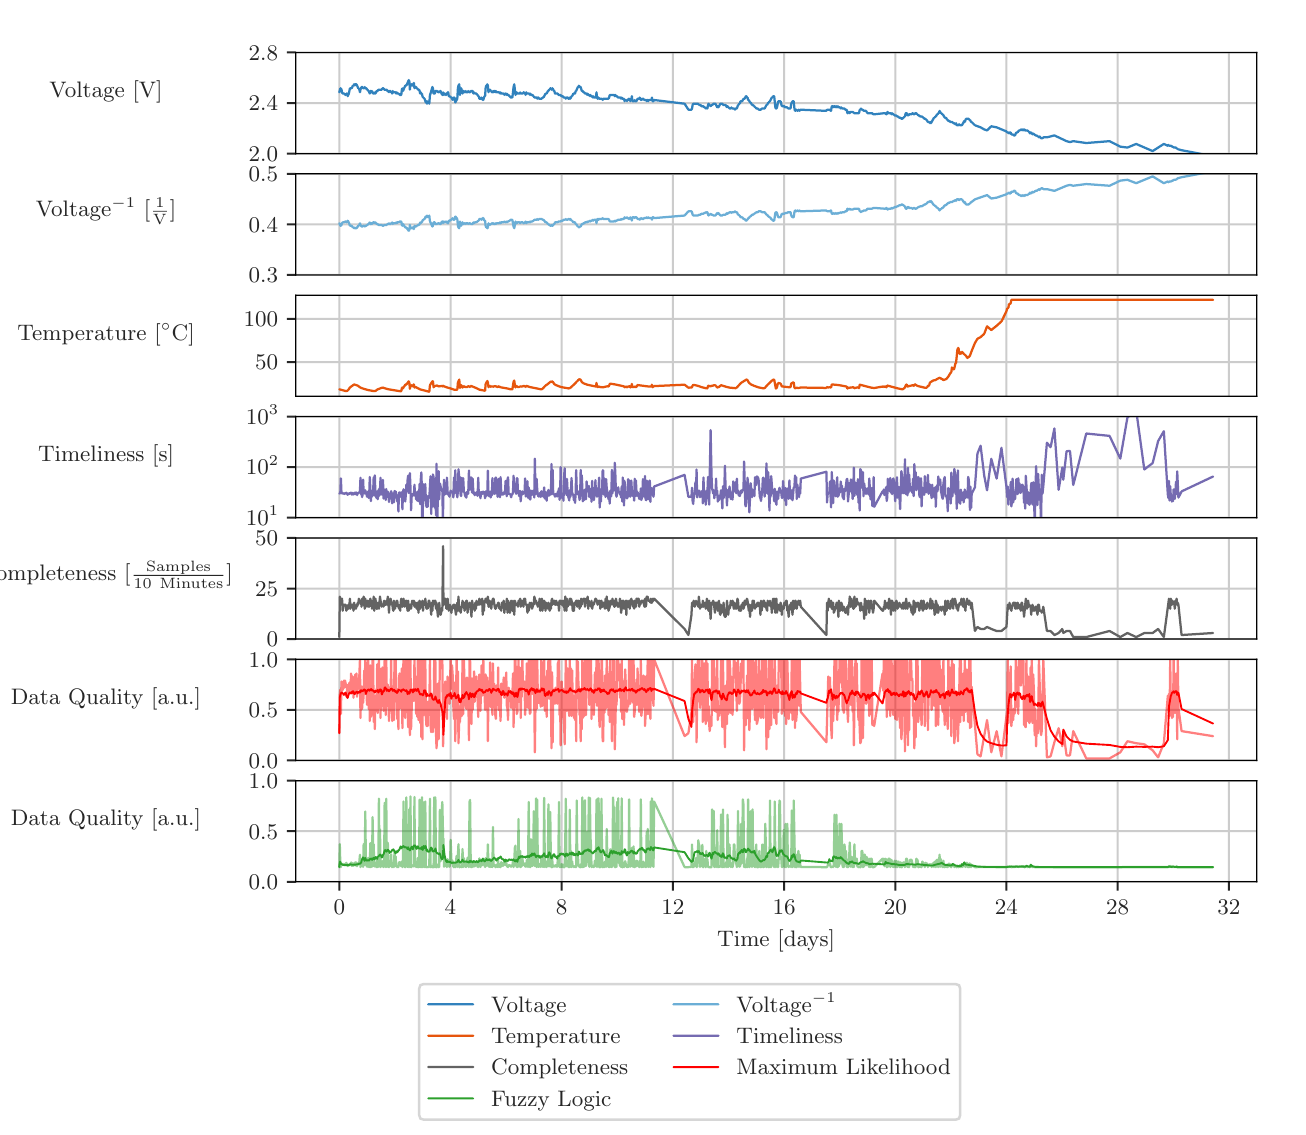
Figure A4. Intel Lab Data Mote ID 46, data quality attributes, measured values, and data quality